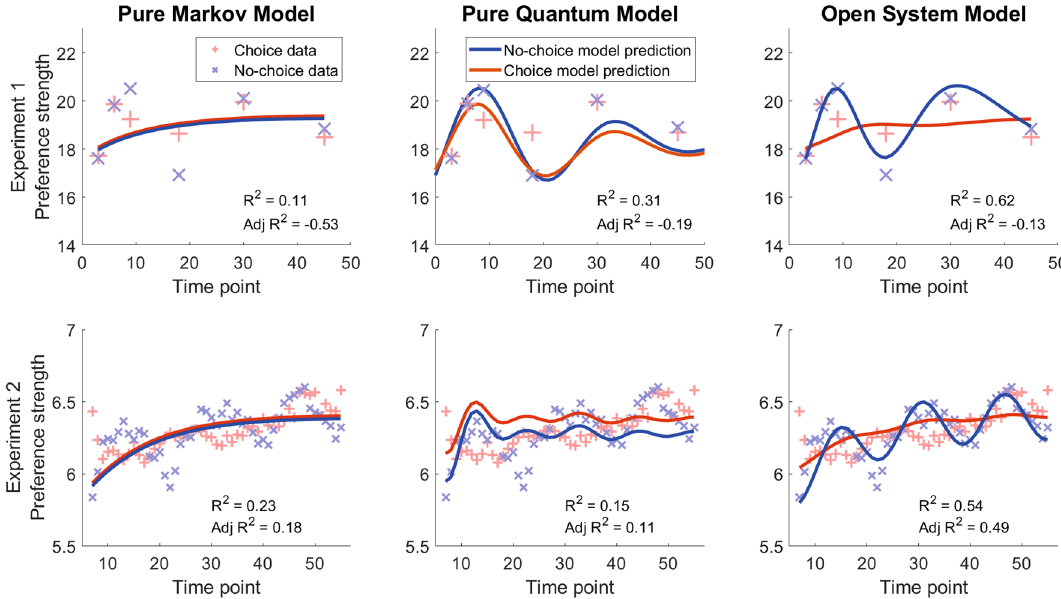
Figure 3. Best-fit trajectories of mean preference strength generated from the Markov (left), quantum (middle), and hybrid open system (right) models for each of the experiments. Data from the experiments are presented as red + (choice condition) or blue (no-choice condition). For Experiment 2, the preference strength data × 3 s window—this pattern does not change are presented as a simple running average of responses within a ± substantially if the window is made wider or narrower, until the window is so wide that it washes out cross-time variability in mean preference. Model predictions (blue/red lines) are computed for every second after the initial response through the last time